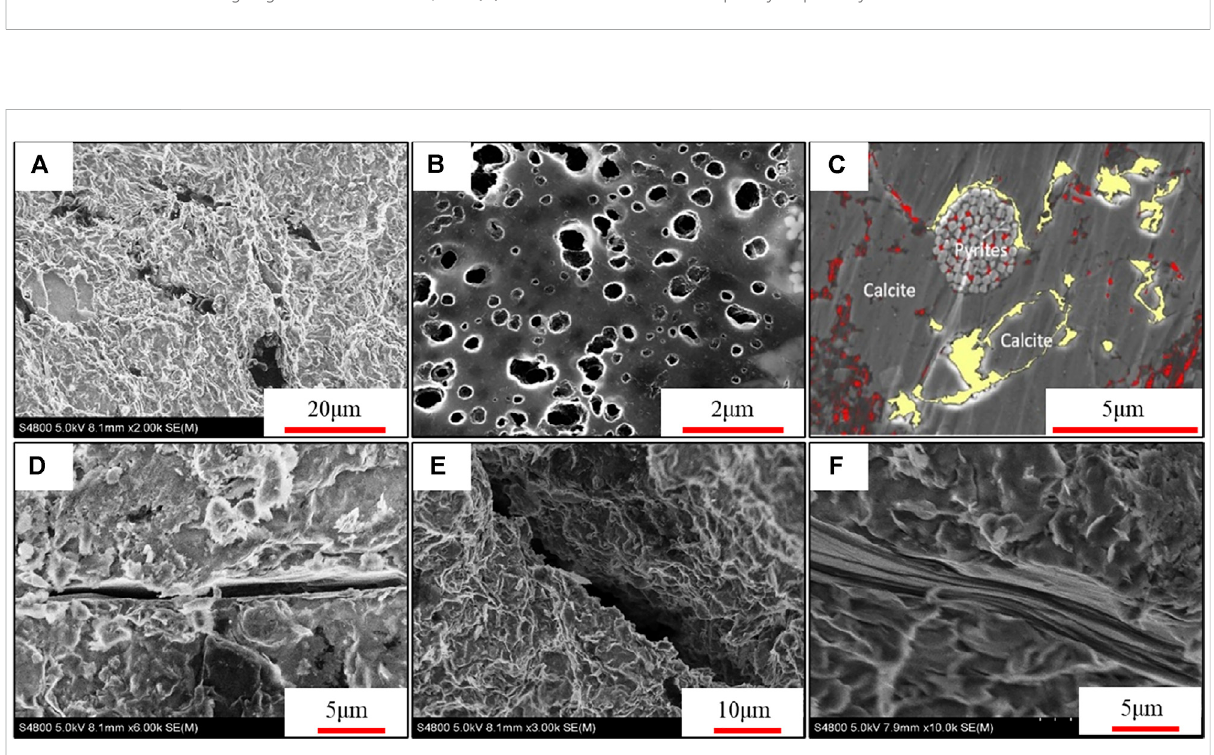
FIGURE 6 SEM images of the pore structure of the Longmaxi Formation shale in the study area. Notes: (A – C) are taken from the Changning Block, and (D – F) are taken from the Luzhou Block. (B) and (C) are from Shi et al., 2022.